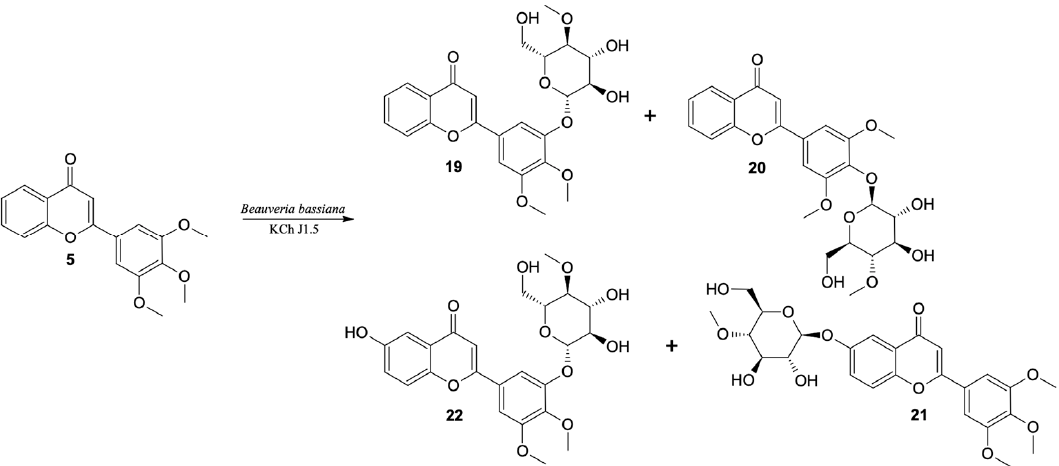
Figure 9. Biotransformation of 3 ′ ,4 ′ ,5 ′ -trimethoxyflavone ( 5 ) by B. bassiana KCh J1.5 strain.